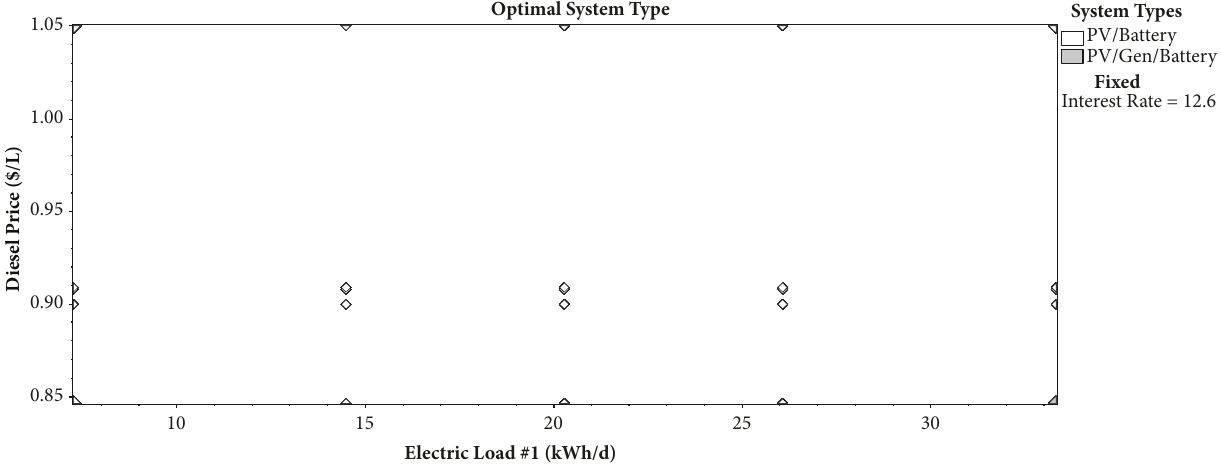
Figure 13: Sensitivity analysis at 16% nominal discount